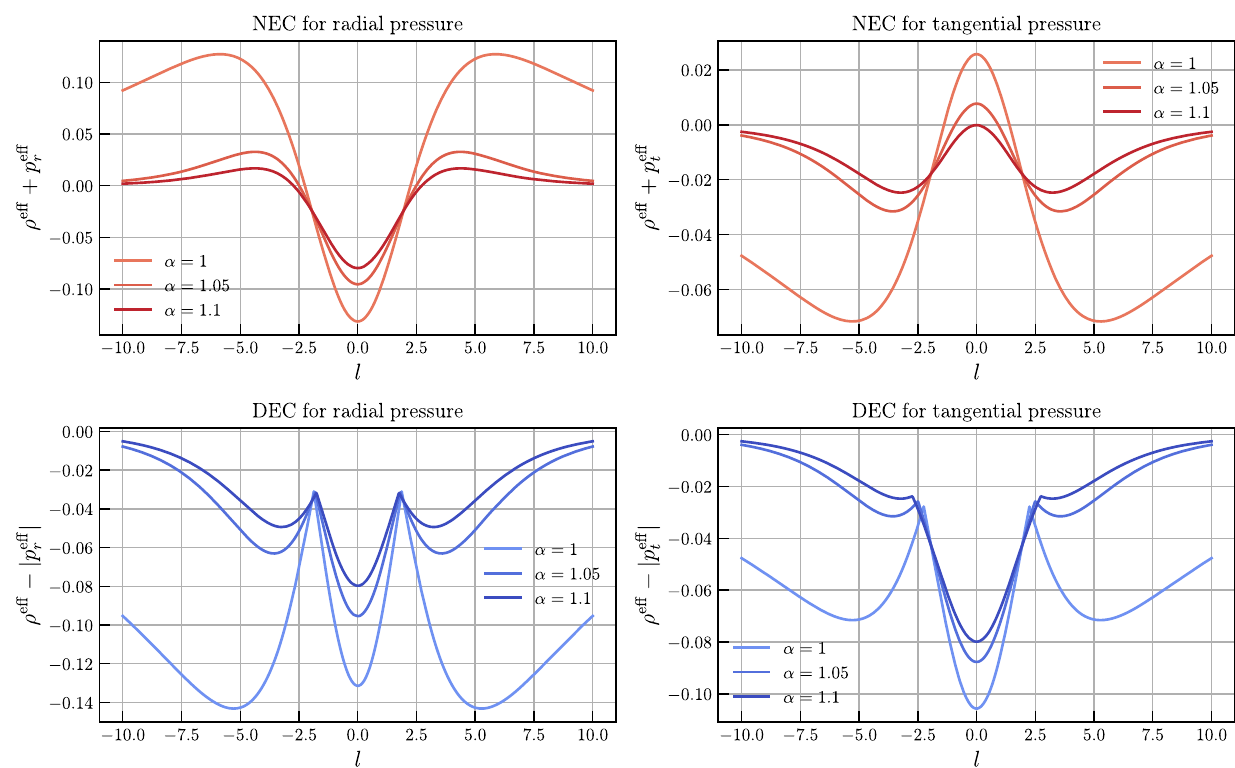
Fig. 3 Null, Dominant and Strong energy conditions for GEB wormhole in the γ f ( R ) gravity. To plot the results, we have considered that wormhole throat is equal to b 0 = 5, cosmological constant is equal to (cid:17) = 1. Furthermore, m = 2 and α = 0 . 5, β = 0 . 1, R ∗ = n =